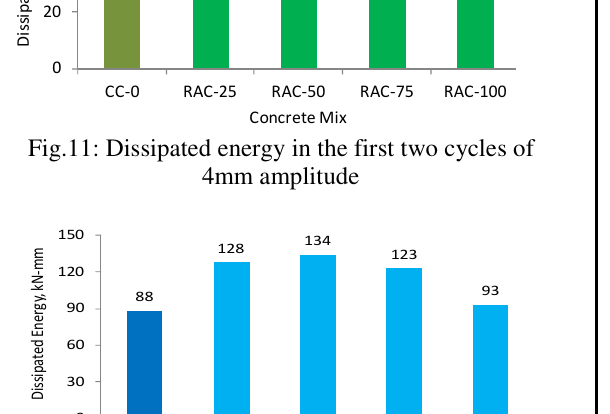
Fig.12: Dissipated energy in the first two cycles of 35mm amplitude